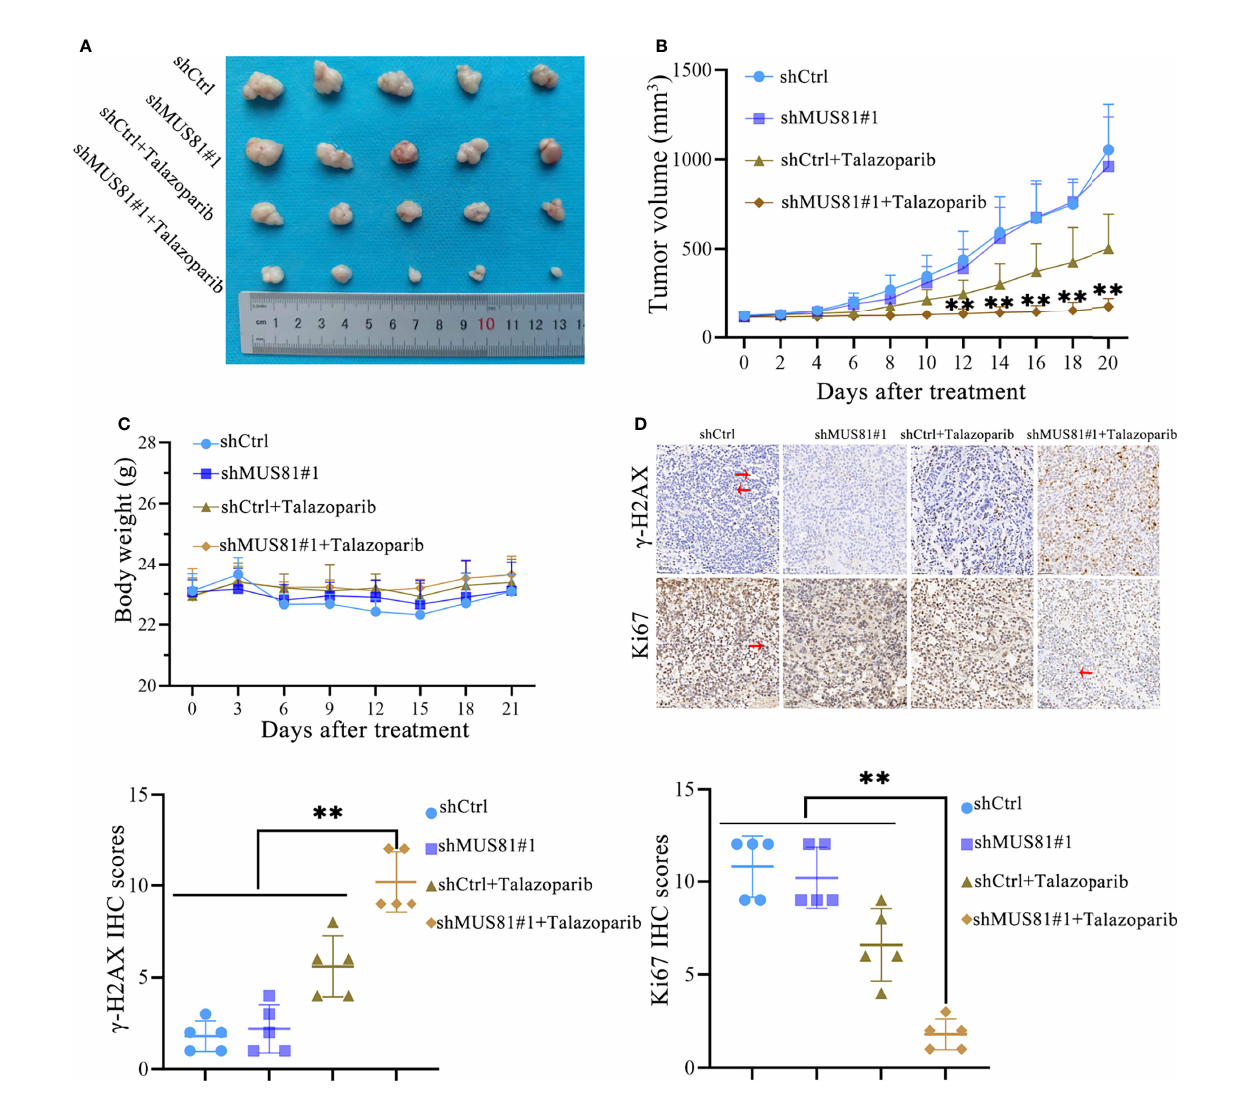
FIGURE 5 | MUS81 knockdown enhances the anticancer ef fi cacy of talazoparib in gastric cancer in vivo . (A, B) Tumor volume of each group on the indicated days of treatment ( t -test). ** P < 0.01. (C) Weight of nude mice on indicated days of treatment ( t -test). (D) Representative images of g -H2AX and Ki-67 immunohistochemistry ( t -test). Positive expression ( ! ). Negative expression ( ← ). Magni fi cation, 200×. ** P <